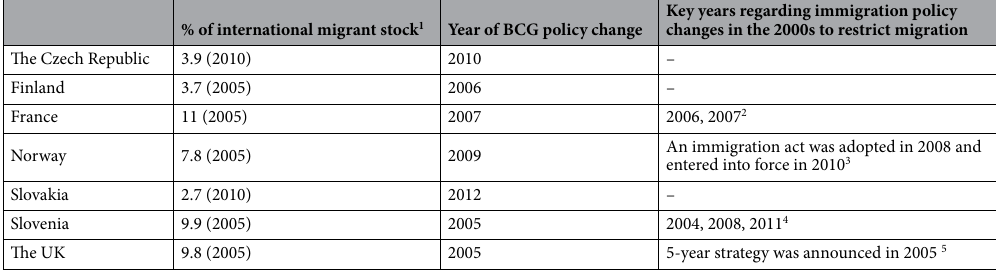
Table 4. International migrant stock among countries that ceased universal BCG vaccination in the 2000s. 1 International migrant stock. World Bank. (https:// data. world bank. org/ indic ator/ SM. POP. TOTL). The data were available every 5 years, and the latest year before the BCG policy change in each country was chosen. 2 Chou, M. H. & Baygert, N. The 2006 French Immigration and Integration Law: Europeanisation or Nicolas Sarkozy’s presidential keystone? ESCR Centre on Migration, Policy and Society Working Paper No. 45 https:// www. compas. ox. ac. uk/ wp- conte nt/ uploa ds/ WP- 2007- 045- Meng- Hsuan- Bayge rt_ French_ Immig ration_ Law. pdf (2007). Kofman, E., Rogoz, M. & Lévy, F. Family migration policies in France. International Centre for Migration Policy Development: NODE Policy Report (2010). 3 International migration 2011–2012 . Norwegian Ministry of Labour https:// www. regje ringen. no/ en/ dokum enter/ inter natio nal- migra tion- 2011- 2012/ id711 645/ (2013). 4 Milohnić, A. An overview of the migration policies and trends—Slovenia. Migrationonline.cz. https:// migra tiono nline. cz/ en/e- libra ry/ an- overv iew- of- the- migra tion- polic ies- and- trends- slove nia (2013). 5